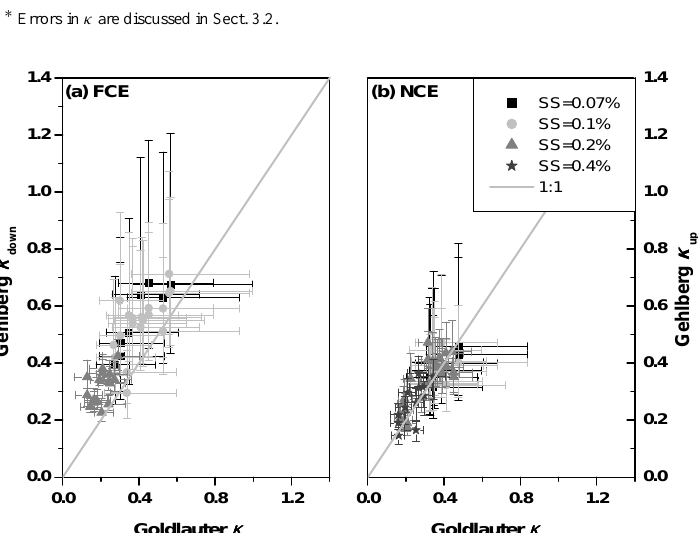
Figure 3. Hygroscopicity parameter κ compared for upwind and downwind stations during the full cloud events (FCE, left panel) and during Fig. 3. Hygroscopicity parameter (cid:20) compared for up- and downwind stations during the Full Cloud Events non-cloud events (NCE, right panel). The error bars represent a maximum absolute error in SS of ± 0.02% for SS ≤ 0 . 2%, and a 10% (FCE, left panel) and during Non Cloud Events (NCE, right panel). The error bars represent a maximum relative uncertainty for SS > 0 . 2% (Gysel and Stratmann, absolute error in SS of (cid:6) 0.02% for SS (cid:20) 0 : 2% and a 10% relative uncertainty for SS > 0 : 2% (Gysel and Stratmann, 2013).